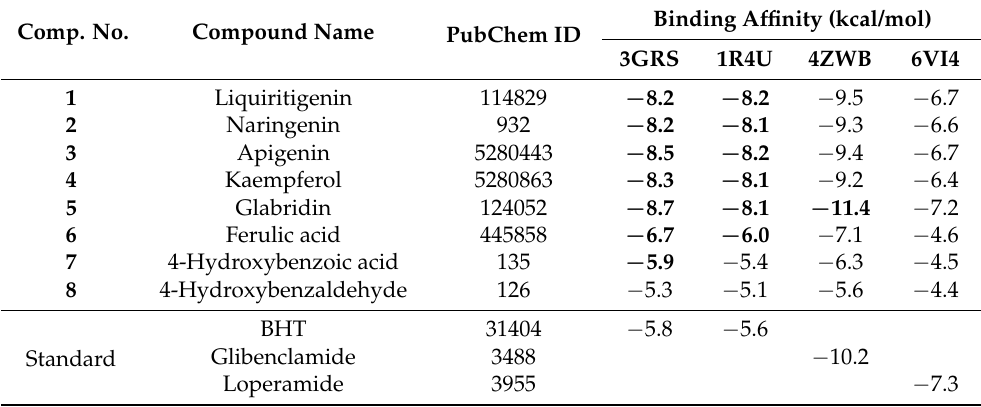
Table 5. The in silico docking scores in terms of binding affinity (kcal/mol) obtained from molecular interactions of the isolated compounds from the Wendlandia tinctoria (Roxb.) DC. stem and the stan- dard drugs butylated hydroxy toluene (BHT), glibenclamide, and loperamide during the interaction with glutathione reductase (PDB ID: 3GRS) and urase oxidase (PDB ID: 1R4U), glucose transporter 3 (GLUT 3) (PDB ID: 4ZWB), and kappa opioid receptor (PDB ID: 6VI4) for assessing the antioxidant, hypoglycemic, and antidiarrheal properties,